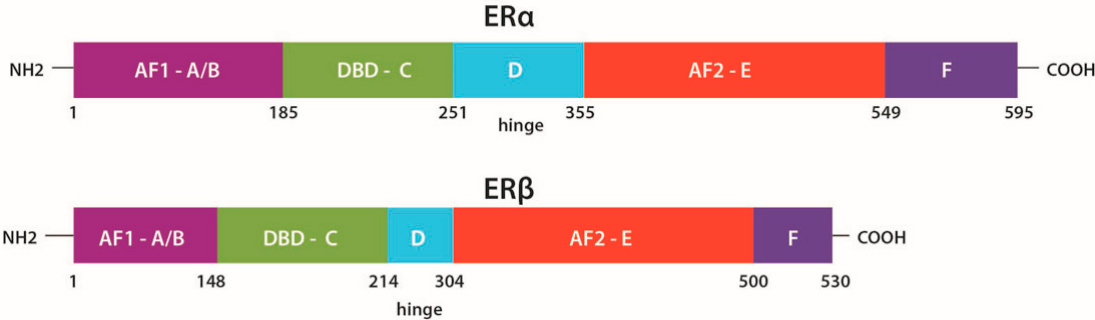
Figure 1. Functional domains of estrogen receptors (ER α and ER β ). Receptor domains are indicated in different colors: Purple, activation factor 1 (AF1) domains A/B; green, DNA-binding domain (DBD) C; blue, heat shock proteins binding domain D; red, activation factor 2 (AF2) domain E; dark purple, C-terminal domain F. Modified from Ng et al. [26].